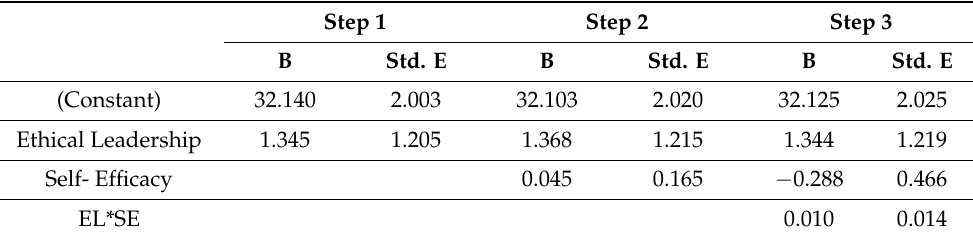
Table 5. Result of hierarchical regression analysis for the effect of ethical leadership on workaholism with moderation effect of